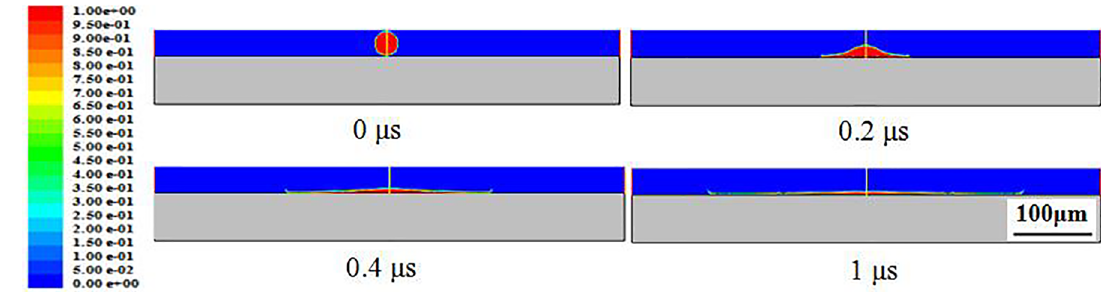
Figure 7. Changes of a droplet deformation and solidification with time for Ø 50 µm and 200 m/s